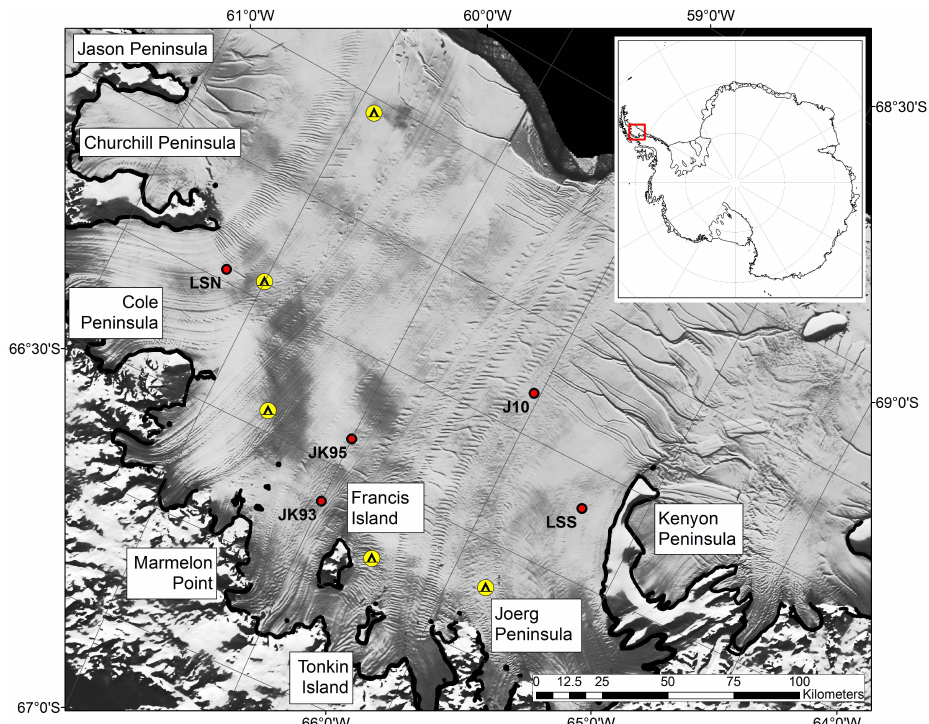
Fig. 1. Larsen C Ice Shelf with MODIS image (Haran et al., 2005) annotated with the main geographical features referred to in the text. Seismic field camps in yellow. Red circles are sites of previously measured ice thickness and water depth: JK93 Seismic (King et al., 1993); JK95 Seismic (Jarvis and King, 1995); LSN/LSS BAS Moorings (Nicholls et al., 2012); J10 Seismic (Kulessa et al., 2010). The grounding line as derived from DInSAR data (Rignot et al., 2011) is represented by the thick black